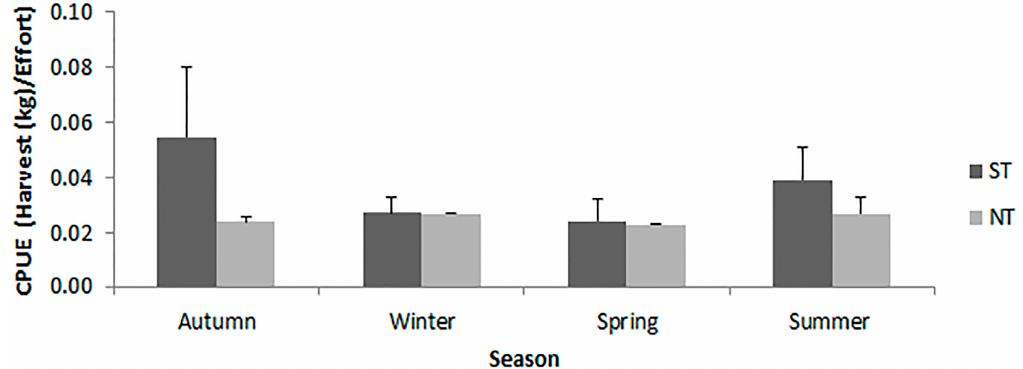
Figure 5. Mean daily values of Catch Per Unit Effort (CPUE) (kg/effort) for seasonal and tidal ranges. ST = spring tide; NT = neap tide. Whiskers show +1 standard error.